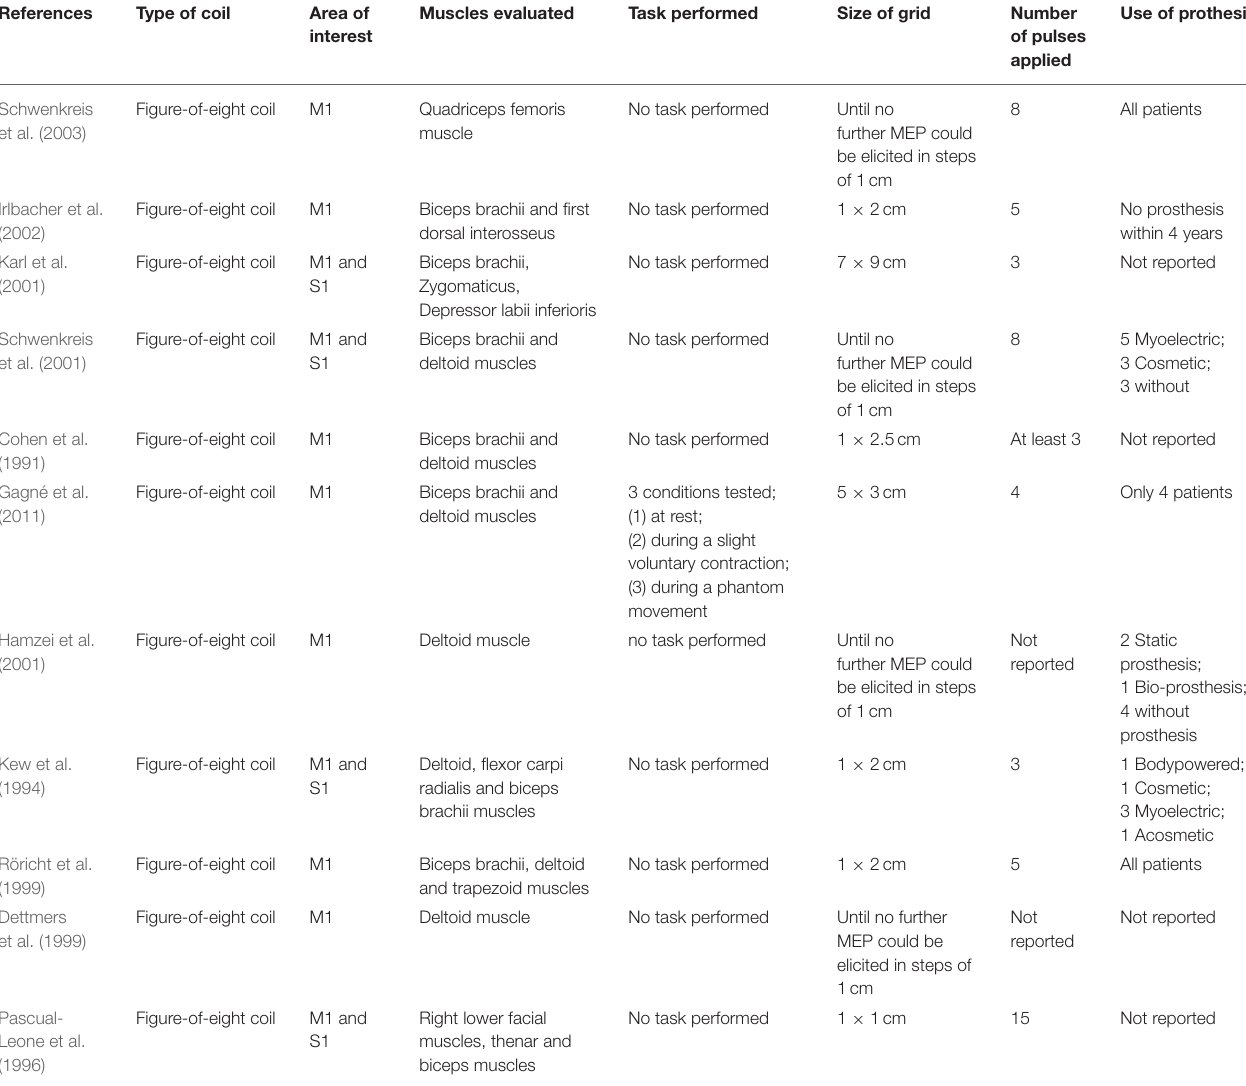
TABLE 2 | Neurophysiological parameters of included studies.